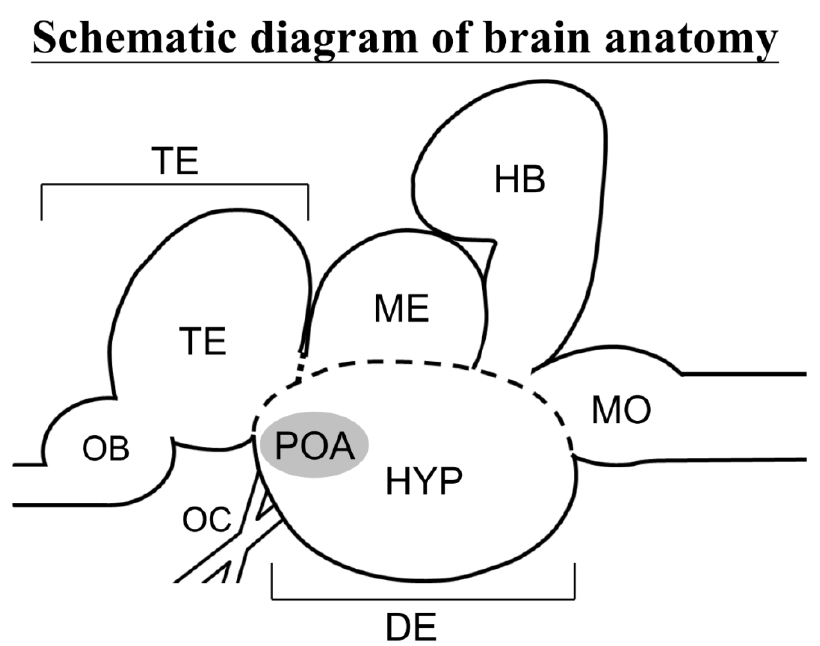
Figure 1. A schematic diagram showing the lateral view of a black porgy brain. DE, diencephalon; HB, hindbrain; HYP, hypothalamus; ME, mesencephalon; MO, medulla oblongata; OB, olfactory bulb; OC, optic chiasm; POA, preoptic area; and TE,